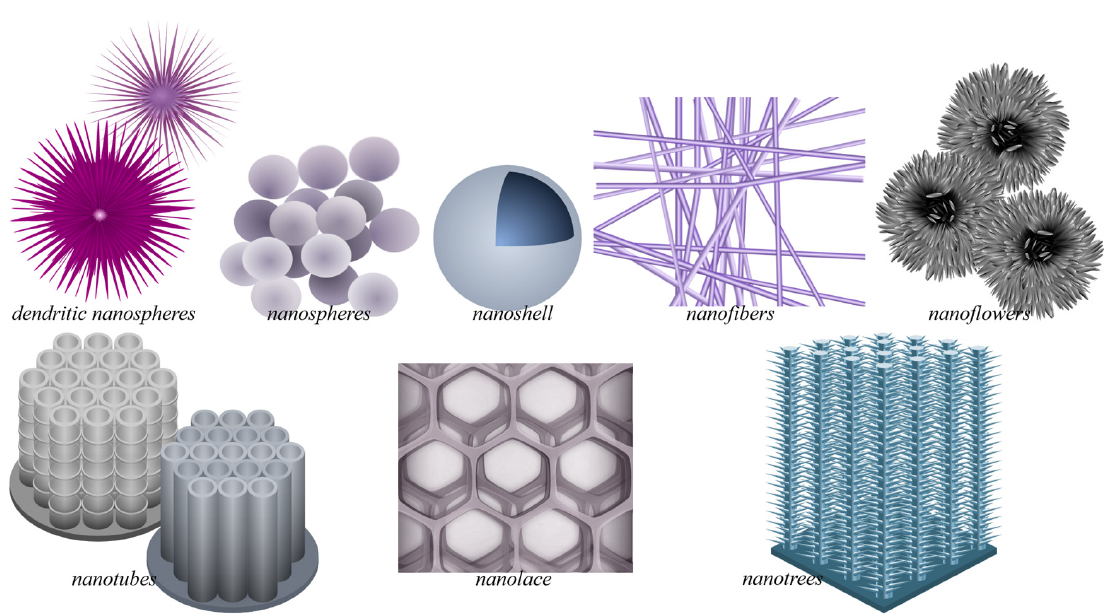
Figure 3. Plethora of TiO 2 nanostructures. This includes free-standing nanomaterials, such as TiO 2 dendritic nanospheres, nanospheres, nanoshells, nanofibers, and nanoflowers, and nanostructures grown on bulk substrates, such as nanotubes, nanolace, and nanotrees. Nanomaterials present increased catalytic activity due to their interesting properties (increased surface area, enhanced charge separation, light absorption/harvesting), which are desirable in catalytic TiO 2 applications. Table 1. Reported photocatalytic performance of some TiO 2 nanomorphologies. Synthetic Procedure Photocatalytic Performance § Targeted Ref. Applications